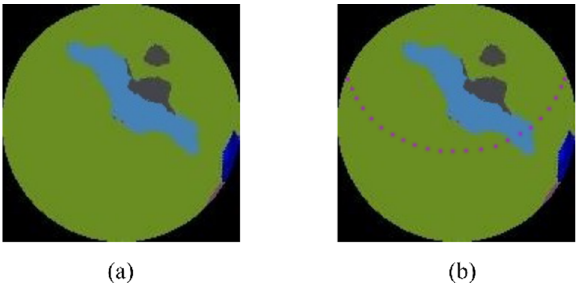
Figure 5. The path of the sun is superimposed on a fisheye image in Beijing (1st August 2018). ( a ) Fisheye image based on semantic segmentation results. ( b ) Fisheye image after overlaying the sun’s path.